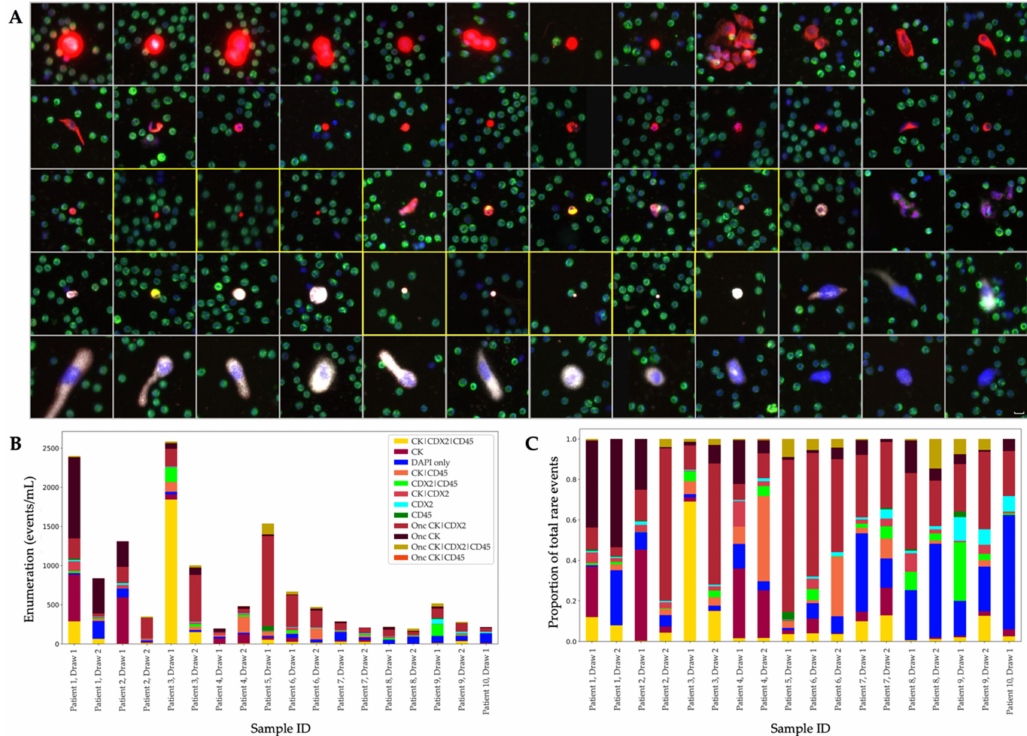
Figure 3. CDX2-targeted samples analyzed by OCULAR. ( A ) Representative rare-event gallery. DAPI: blue, cytokeratin (CK): red, CDX2: white, CD45: green. Events from each of the 10 patients are represented in the gallery. The eight oncosomes displayed are bordered by yellow boxes. Events are ordered by decreasing CK intensity. Images taken at 100 × magnification. Scale bar for all images is shown in the bottom right cell, representing 10 µ m. ( B ) Enumeration (events/mL) of each channel classification per patient and draw. ( C ) Frequency (%) of each channel classification per patient and